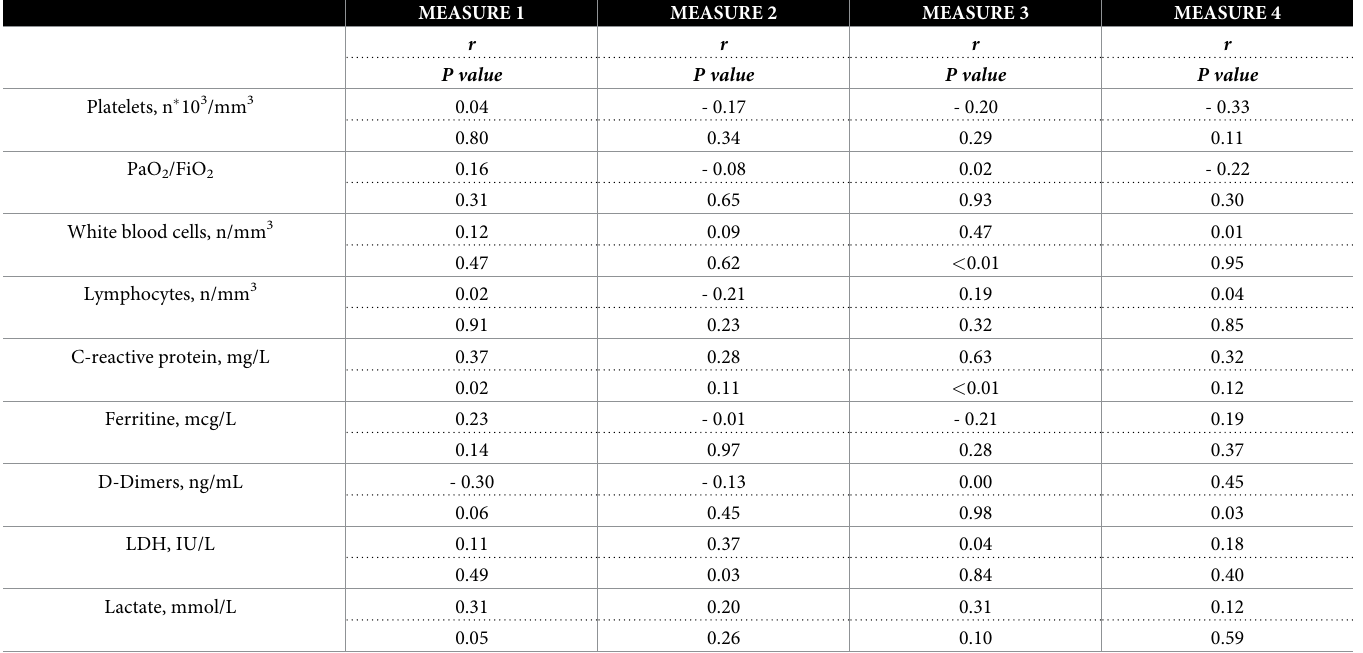
Table 2. Correlation between IL-6 and different biochemical